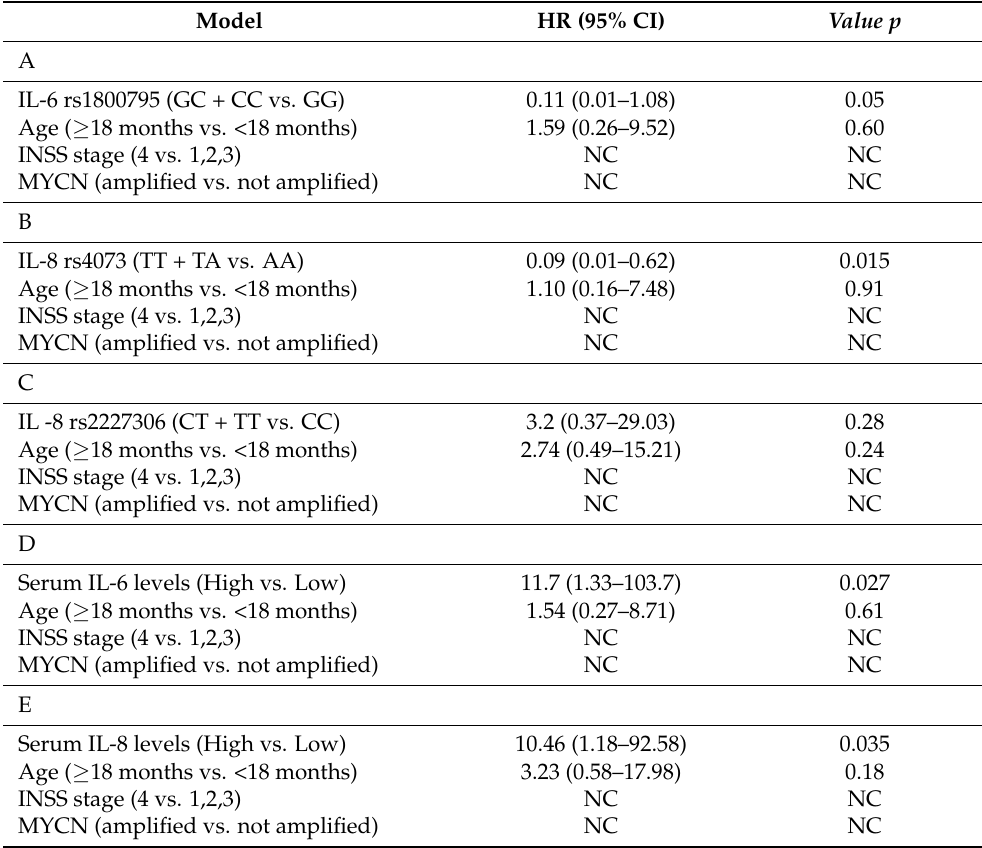
Table 9. Results of the multivariate Cox proportional hazards